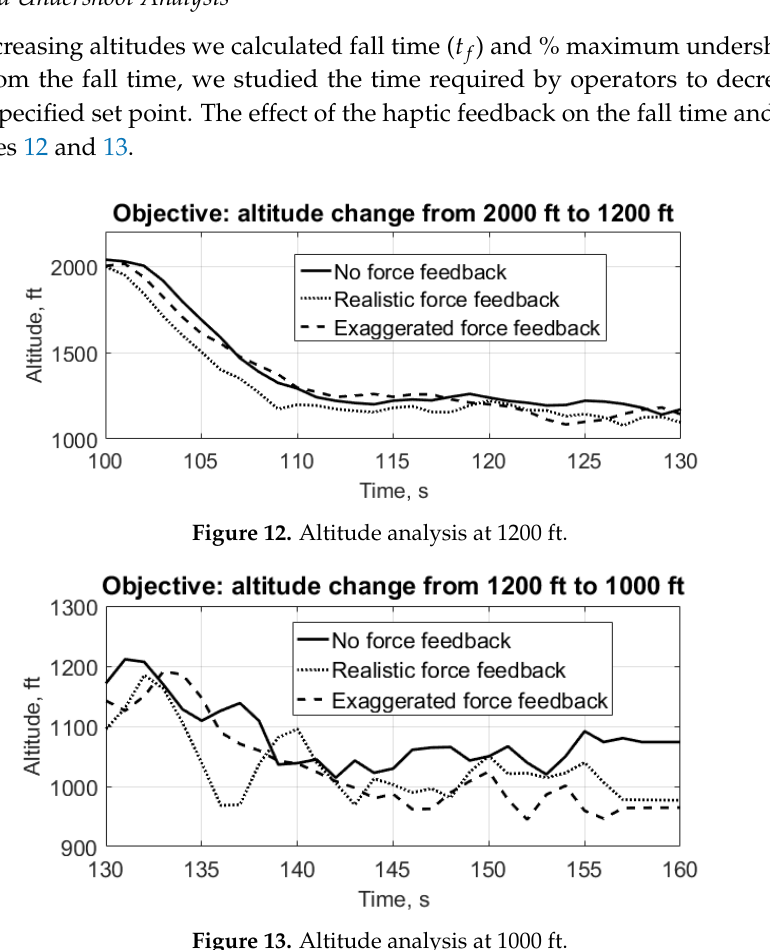
Figure 13. Altitude analysis at 1000